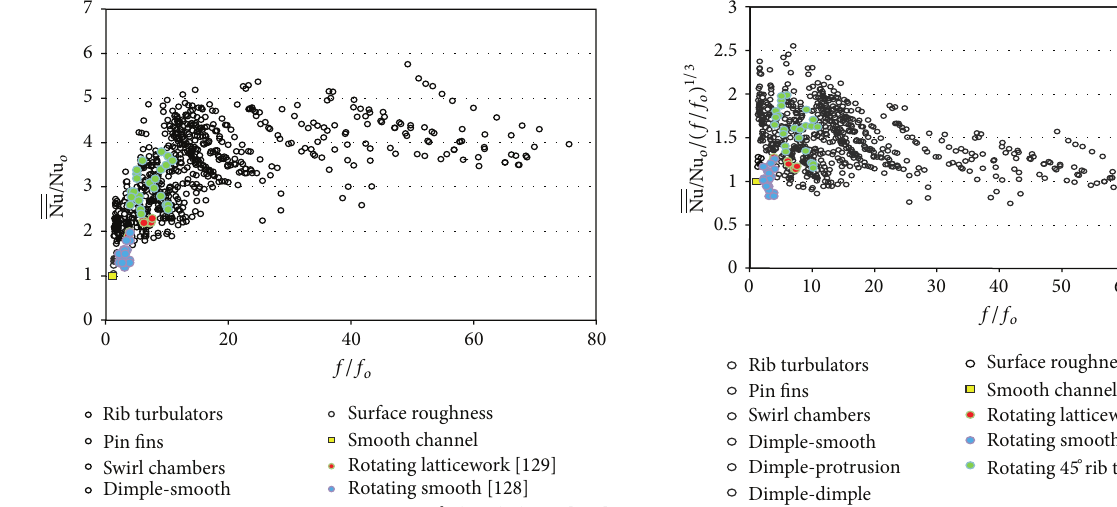
Figure 31: Comparisons of relative performance of rib turbulators, pin fins, swirl chambers, dimple-smooth arrangements, dimple- protrusion arrangements, dimple-dimple arrangements, surface roughness, and smooth-walled channels [1], with results from rota- tion experiments [128, 173]. Globally averaged thermal performance parameters Nu / Nu 𝑜 /(𝑓/𝑓 𝑜 ) 1/3 are presented as dependent upon friction factor ratios 𝑓/𝑓 𝑜